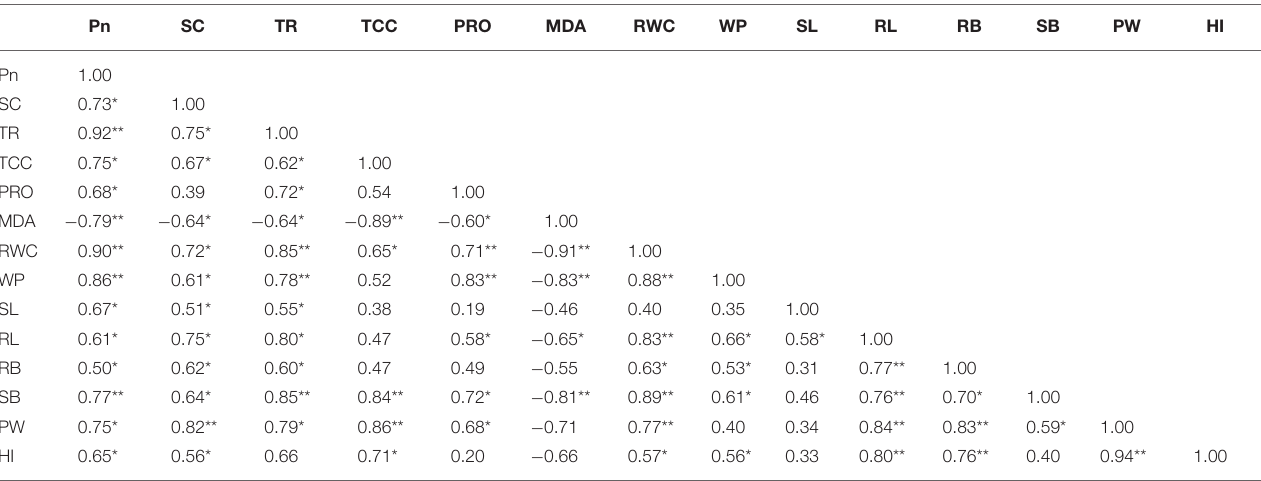
TABLE 4 | Correlation analysis among various physio-biochemical and growth parameters. Pn SC TR TCC PRO MDA RWC WP SL RL RB SB PW HI Pn